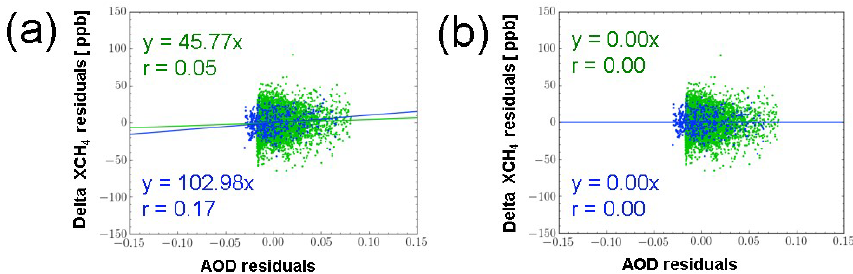
Figure 3. Scatter diagrams between (cid:49) XCH 4 calculated from (a) uncorrected and (b) corrected GOSAT data and the retrieved aerosol optical depth. Green (blue) dots and lines indicate the GOSAT data and the regression lines over land (ocean) regions.